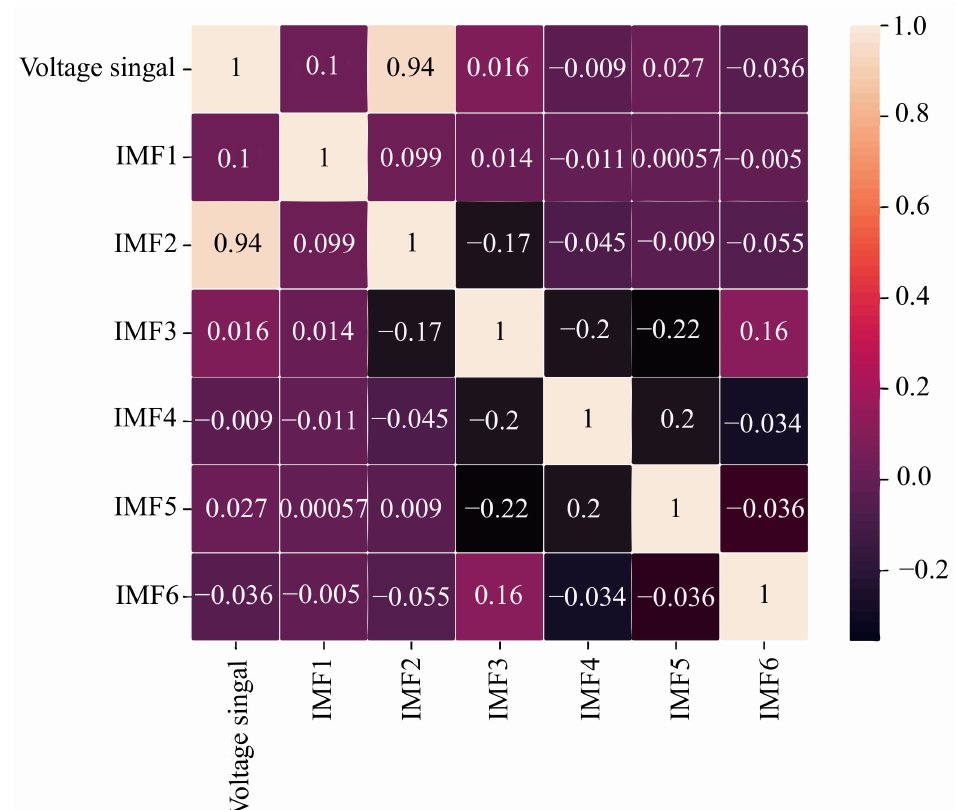
Figure 8. The Spearman rank correlations between the IMFs and the original voltage signal.